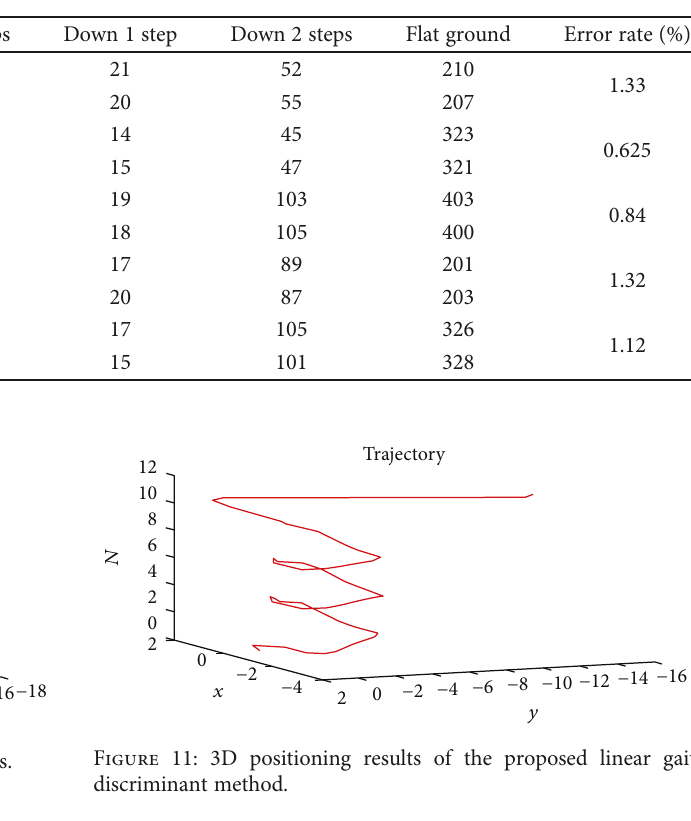
Table 2: Comparison of gait discriminant results among di ff erent pedestrians with actual walking posture.